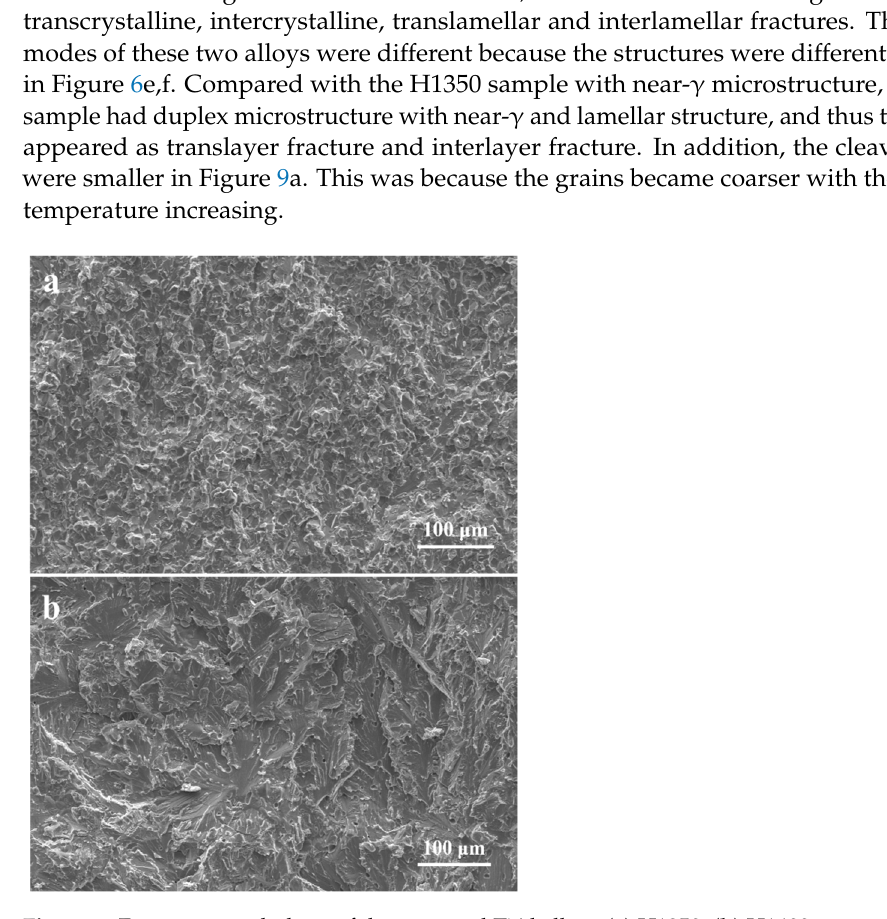
Figure 9. Fracture morphology of the prepared TiAl alloys ( a ) H1350, ( b )